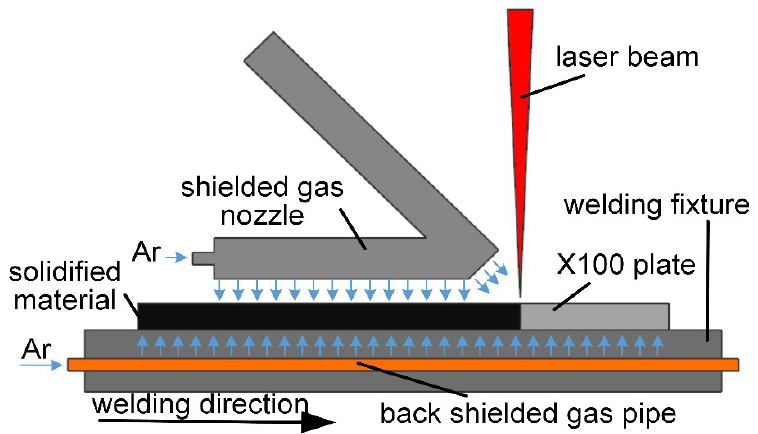
Figure 1. Schematic of the X100 laser-welding device.